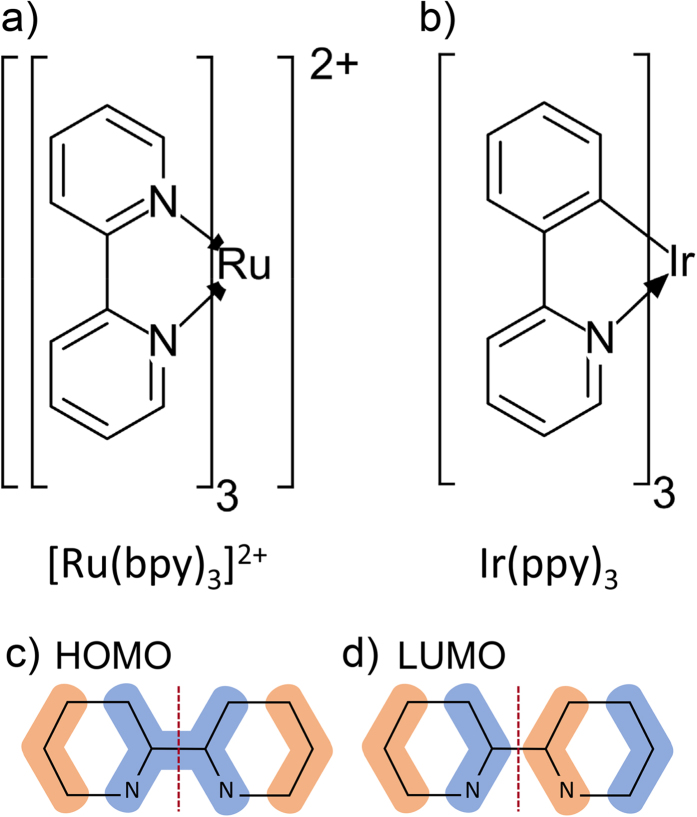
The structures of two important pseudo-octahedral transition metal complexes:a) [Ru(bpy)3]2+ and b) Ir(ppy)3, where bpy is bipyridine and ppy is 2-phenylpyridyl. Sketches of the π (c) and π* (d) orbitals of a bpy ligand with the reflection plane marked by the dashed line. It is clear that these correspond to the bonding and antibonding combinations of singly occupied molecular orbitals of a pyridine radical.